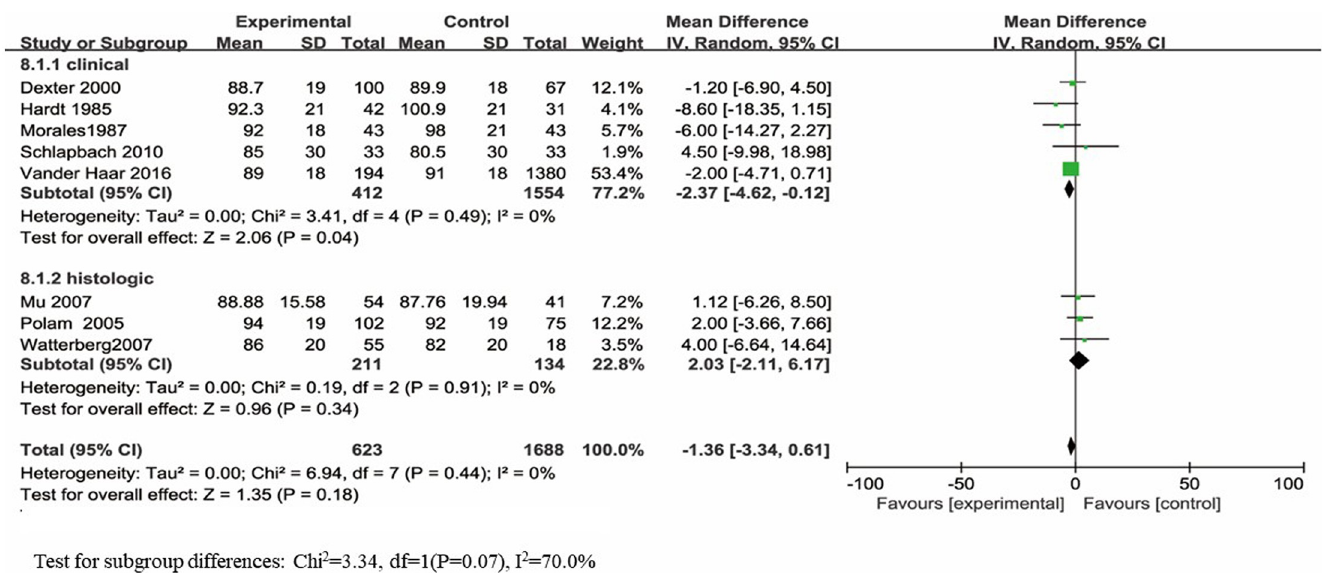
Fig 3. Forest plot of pooled analysis of maternal chorioamnionitis and the PDI in offspring.